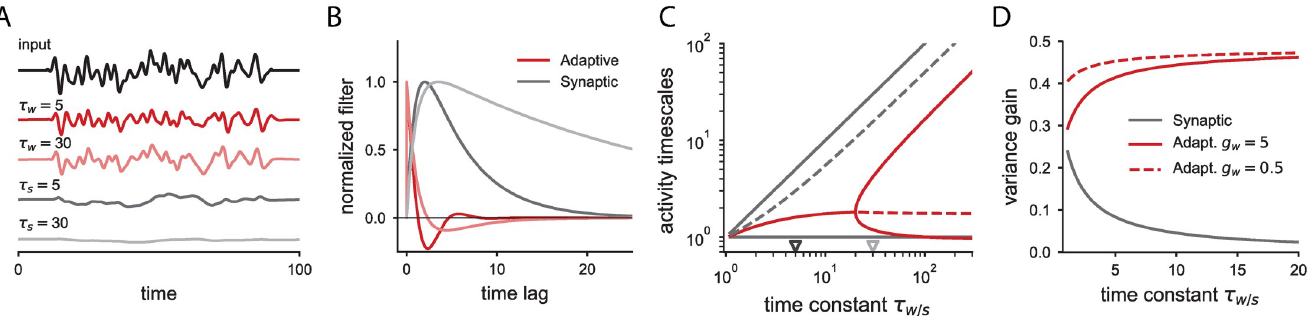
Fig 1. Activity of individual neurons with adaptation or synaptic filtering. A: Firing rate response of two different neurons with adaptation (red curves) and two different neurons with synaptic filtering (grey curves) to the same time-varying input (black curve). B: Normalized linear filters for the neurons shown in A. C: Timescales of the linear filter for neurons with adaptation (red lines) and for neurons with synaptic filtering (grey lines) as a function of the timescale τ w or τ s , respectively. The dashed lines indicate the effective timescale of the evoked activity obtained by weighing each individual timescale with its amplitude in the linear filter. The effective timescale for neurons with adaptation saturates for large adaptation time constants, while it grows proportionally to the synaptic time constant for neurons with synaptic filtering. Note that for the adaptive neuron, if the two eigenvalues are complex conjugate, there is only one decay timescale. The triangles on the temporal axis indicate the time constants used in A and B. Adaptation coupling g = 5. D: Variance of the input current as a function of the slow time constant when w the adaptive and synaptic neurons are stimulated with Gaussian white noise of unit variance. In the case of neurons with adaptation, two different values of the adaptation coupling g are shown. Time in units of the membrane time constant τ . w m